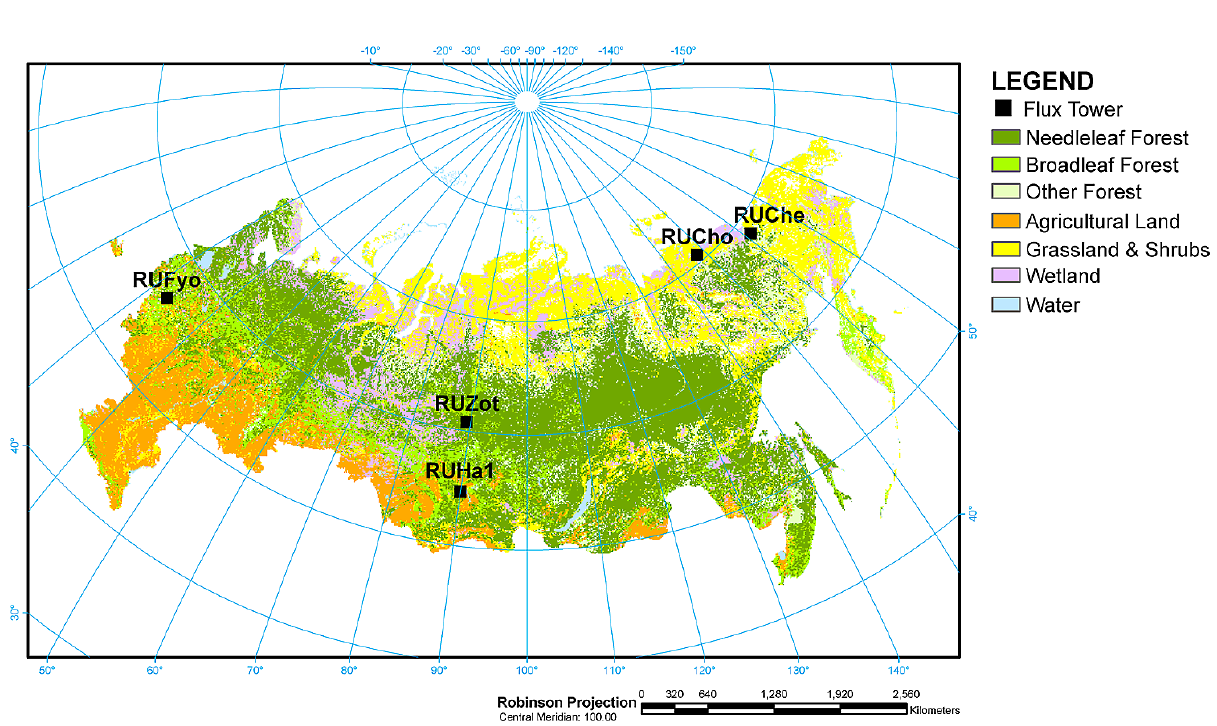
Fig. 1. Map of dominant Russian land cover (Schepaschenko et al., 2011), along with locations of the flux towers used in this